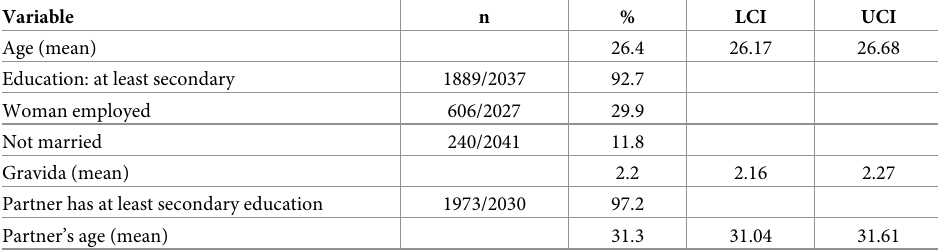
Table 1. Socio-demographic characteristics of the sample (N = 2042).